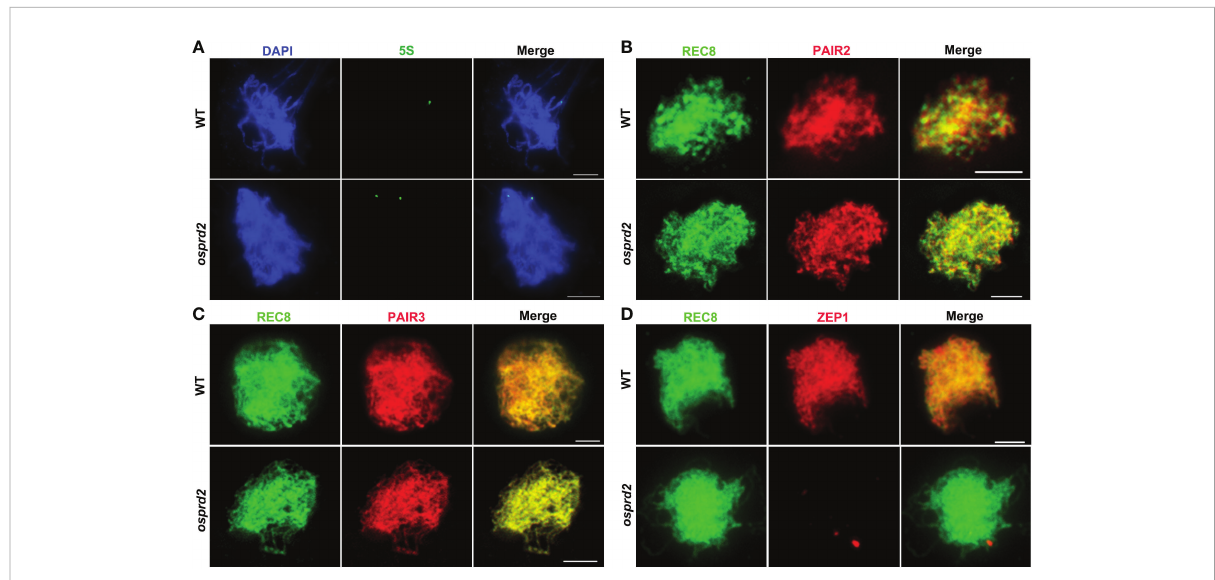
FIGURE 4 Homologous chromosome pairing and synapsis were disrupted in osprd2 . (A) is 5S probe (green) signal in WT and osprd2 mutant in zygotene; (B – D) are distribution of synapsis complex element PAIR2 (B) , PAIR3 (C) and ZEP1 (D) (red) in WT and osprd2 mutant in zygotene, REC8 signals (green) were used to indicate the meiotic chromosome axes. Bar=2 m